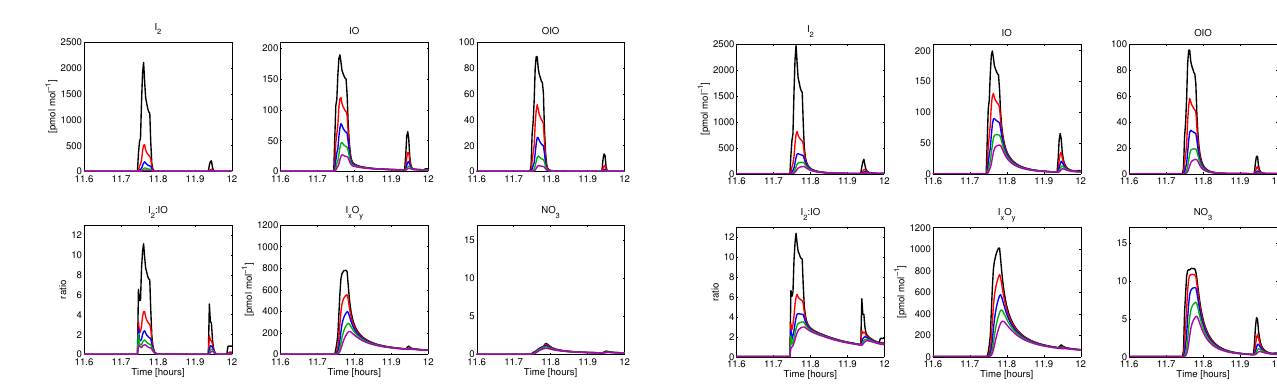
Fig. 10. Mixing ratios of I 2 , IO, OIO, I x O y , NO 3 , and ratio of I 2 :IO, in the lowest five layers of the model column for the I 2 re- cycling, low tide, model run. Black, red, blue, green, and purple lines represent levels with their centres at 0.5, 2, 4.5, 8 and 12.5m,